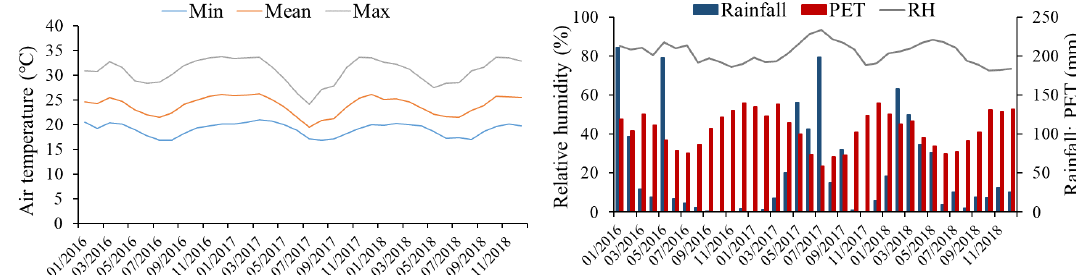
Figure 2. Time series for air temperature, monthly rainfall and potential evapotranspiration (PET), and relative humidity. Jatobá Basin, Pesqueira-PE,